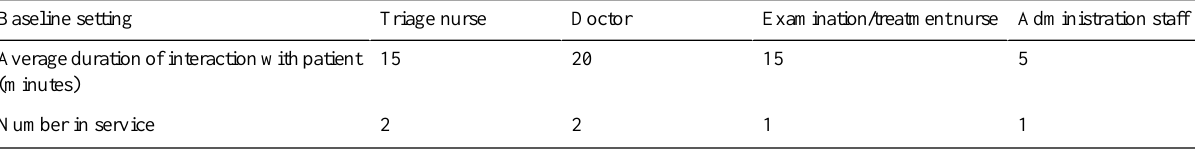
Table 1. Baseline settings for simulation of the urgent care